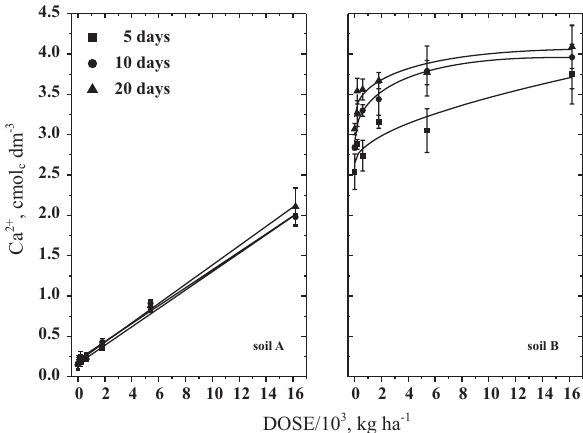
Figure 3. Exchangeable calcium under increasing doses of solid residue in soils A and B. Table 3 shows the fitted parameter values according to the algebraic model adjusted for Ca 2+ response.